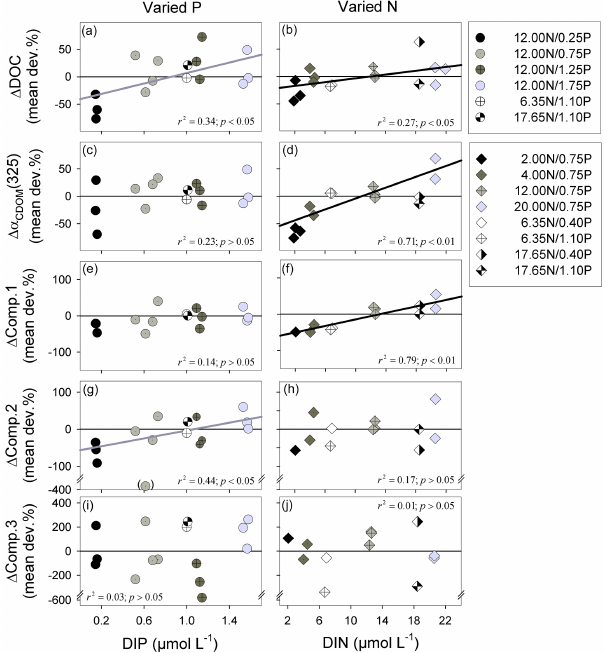
Figure 5. Mean normalized deviations of DOM accumulation against initial nutrients supply. The (cid:49) DOC against DIP initial sup- ply in Varied P (a) and against DIN initial supply in Varied N (b) , the CDOM absorption ( (cid:49)a CDOM (325)) against DIP initial supply in Varied P (c) and against DIN initial supply in Varied N (d) , the first FDOM component intensity ( (cid:49) Comp.1) against DIP ini- tial supply in Varied P (e) and against DIN initial supply in Varied N (f) , the second FDOM component intensity ( (cid:49) Comp.2) against DIP initial supply in Varied P (g) and against DIN initial supply in Varied N (h) and the third FDOM component intensity ( (cid:49) Comp.3) against DIP initial supply in Varied P (i) and against DIN initial supply in Varied N (j) are shown as dashed symbols. The linear re- gressions are shown by thick light-gray lines in Varied P and by thick black lines in Varied N for those DOM parameters, where co- variance with initial nutrients supply was significant. The symbol in brackets in (g) was considered as an outlier and excluded from linear regression